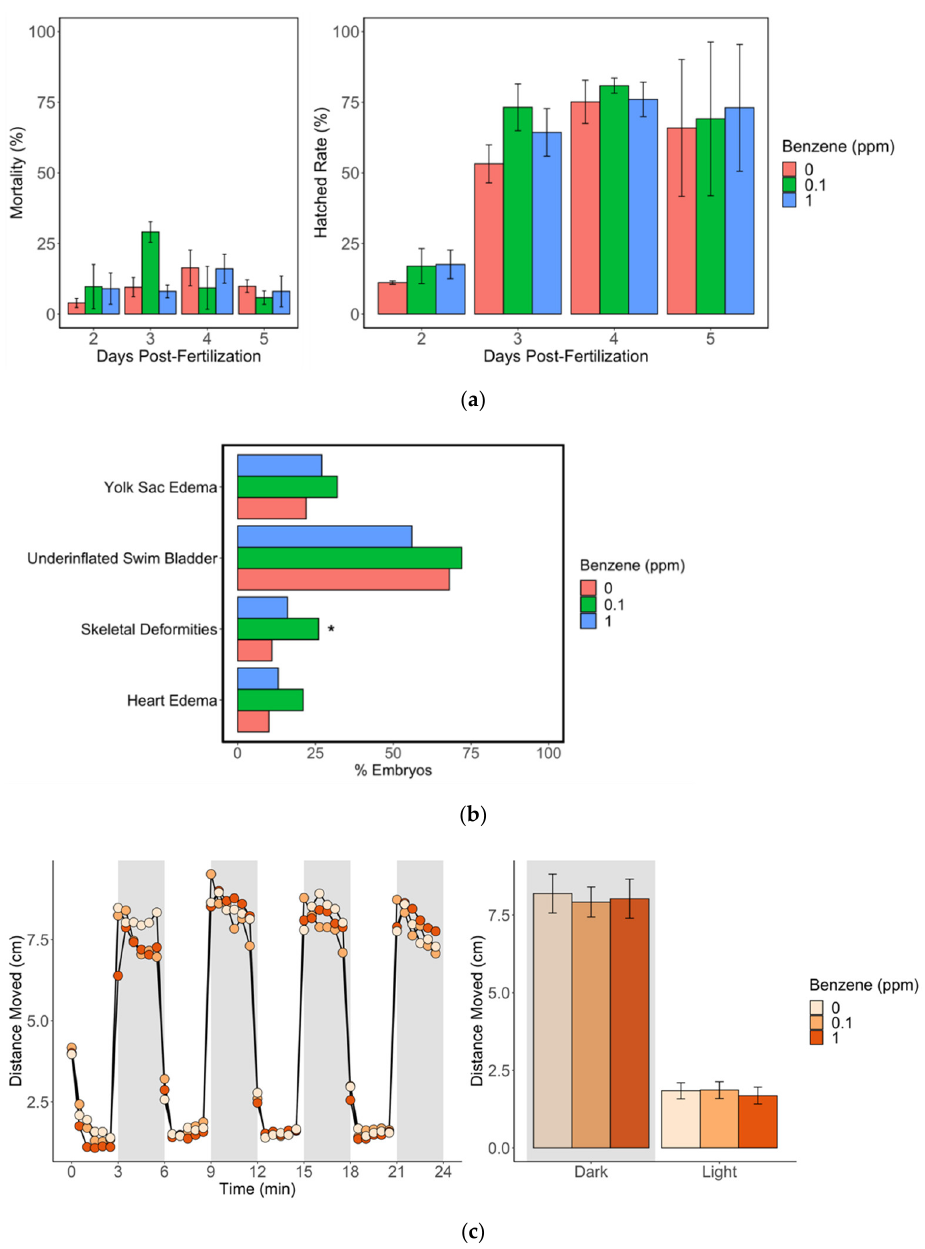
Figure 1. Phenotypic responses following benzene exposure from 4 h post-fertilization (hpf) to 5 days post-fertilization (dpf). ( a ) Average mortality ( left ) and hatch rate ( right ) of live embryos over the course of exposure period (n = 740 per treatment); ( b ) percentage of embryos with morphological abnormalities at 5 dpf per treatment (n = 134, 149, 146 for 0, 0.1, and 1 ppm benzene); or ( c ) average distance moved by larval zebrafish during light and dark cycles (n = 32 per treatment). * Condition is significantly different from control (0 ppm; p <